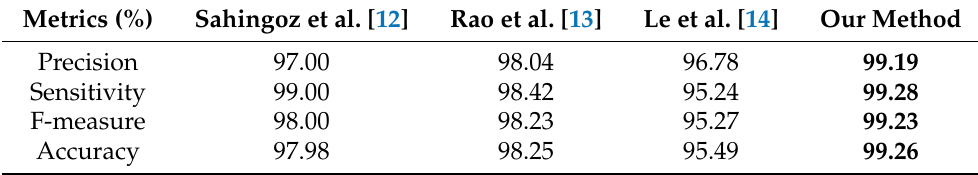
Table 8. Comparison of the proposed model with existing baseline models on